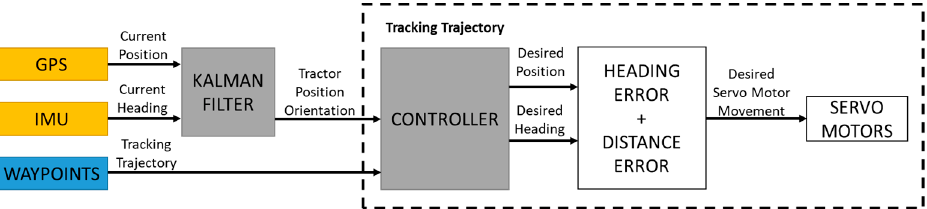
Figure 6. Waypoint system overview.